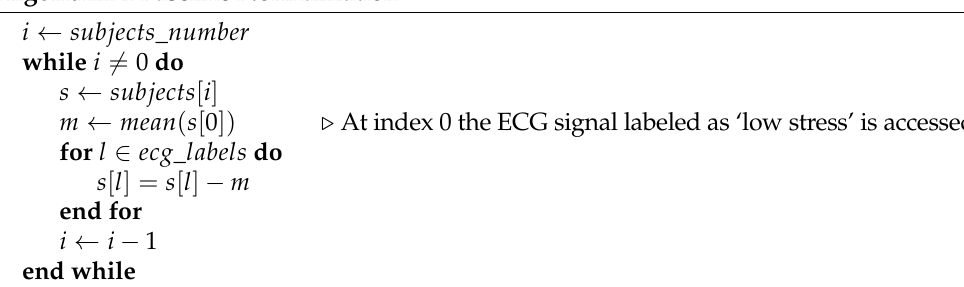
Algorithm 1 Baseline